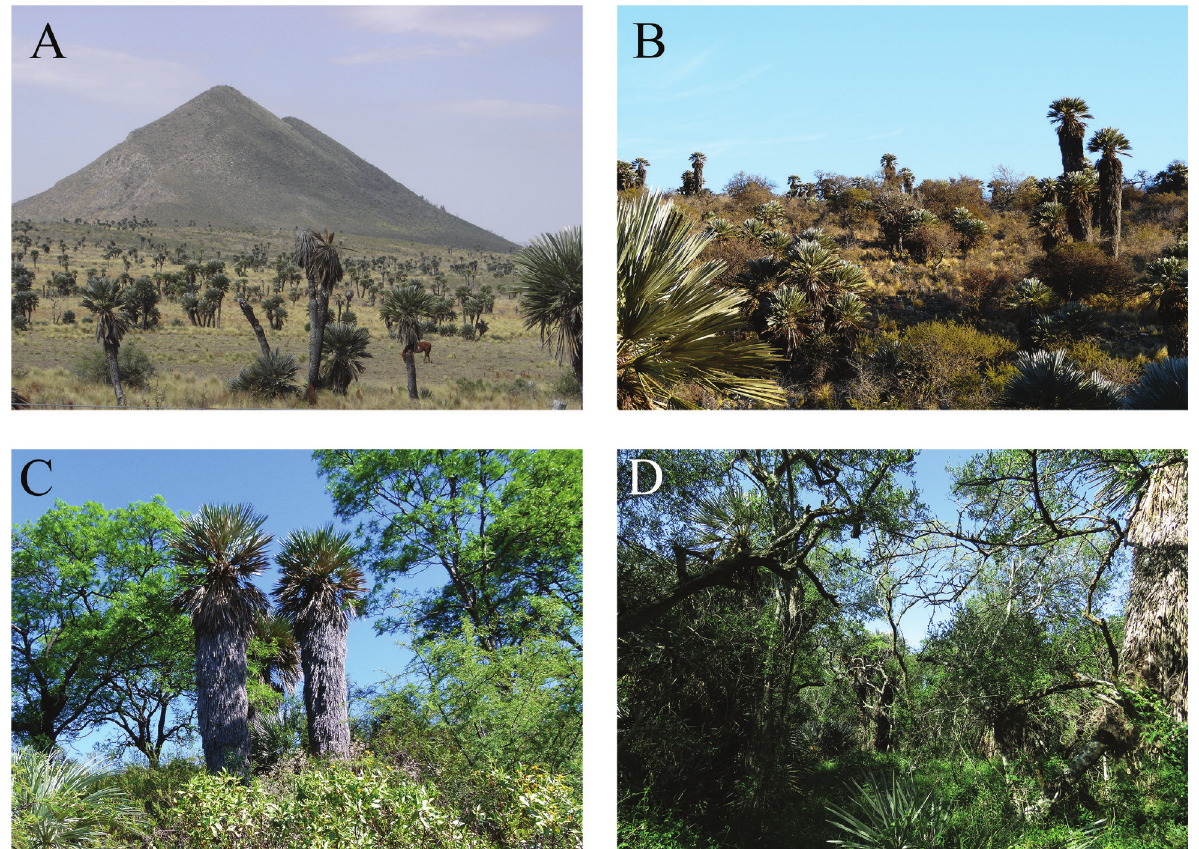
Figure 2. Examples of vegetation types comprising Trithrinax campestris in the study area in central Argentina. A Palm savanna with T. campestris in a matrix of grasslands on gentle hillside slopes; B Scrubland dominated by Vachellia caven and T. campestris on rocky soils; C Mountain Chaco forest dominated by Schinopsis marginata with scattered individuals of T. campestris on steep mountain slopes; and D Espinal forest with Celtis tala , Prosopis nigra and T. campestris on deep soils in lowland